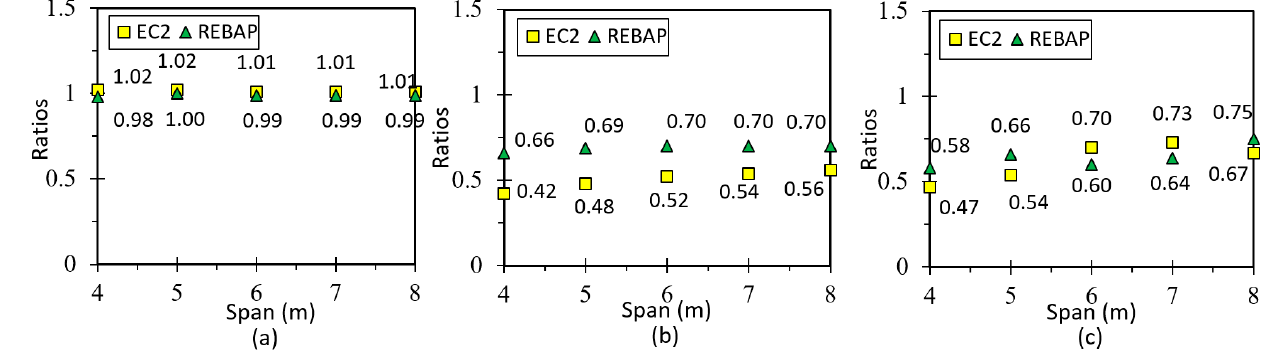
Figure 18. Ratios values for ( a ) LM, ( b ) 1NLM and ( c ) 2NLM, for simply supported slab.